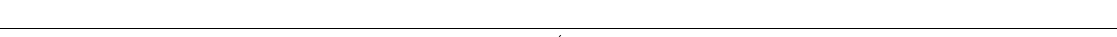
Fig. 2 Retinal degeneration and synaptic dysfunction present in dSms e/e fl ies. a – f Eye exterior morphology of fl ies at different ages. Note the loss of pigments of 30 DAE dSms e/e fl ies ( e black dashed outline). a ′ – f ′ Representative traces from ERG recordings showing light-induced depolarization and on/off responses (black arrow heads). g – i Quanti fi cation (mean ± S.E.M.; n = 11 (control, 2 DAE), 10 (control, 30 DAE), 14 ( dSms e/e , 2 DAE), 10 ( dSms e/e , 15 DAE), 10 ( dSms e/e , 30 DAE), 10 ( dSms RA rescue, 30 DAE) fi eld recordings from four animals) of on transient ( g ), off transient ( h ), and depolarization ( i ) of ERG at different ages. j Three-dimensional schematic showing lamina synapses (yellow box) formed by photoreceptors (green) and lamina neurons (L1 – L2, red). Cross sections on the xy -plane and xz -plane are drawn for reference. k TEM micrographs of lamina cartridges (cross sections on the xy -plane; glia, blue; presynaptic terminals, green; post-synaptic terminals, red). l TEM micrographs of individual presynaptic terminals showing different types of membrane structures (type I-IV, indicated by asterisk) present in dSms e/e fl ies. m Quanti fi cation (mean ± S.D.; n = 32 for control and 29 for dSms e/e cartridges from three animals) of abnormal membrane structures observed in k . n TEM micrographs showing presynaptic mitochondria (green dashed outline) and post-synaptic mitochondria (red dashed outline) in lamina. o Quanti fi cation of presynaptic (green) and post-synaptic (red) mitochondria area (median with 10 – 90th percentile; n = 115/120 for control pre/post-synaptic terminals, and 93/79 for dSms e/e pre/post-synaptic terminals), number per cartridge (mean ± S.E.M., n = 25 for control and dSms e/e cartridges), and percentage of cartridges possessing mitochondria with abnormal morphology (mean ± S.E.M., n = 25 for control and dSms e/e cartridges). g – i One-way ANOVA post hoc Tukey test; m , o Student t test. * P < 0.05, ** P < 0.01. All scale bars, 1 µ